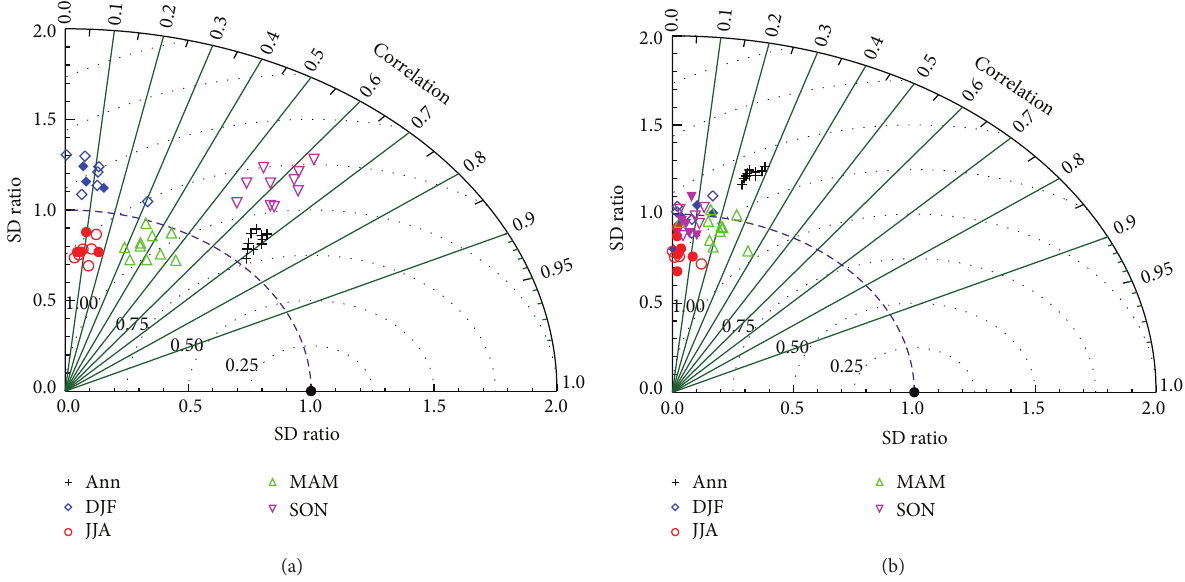
Figure 1: Taylor diagram is displayed in polar coordinate for pattern comparison between reference and other runs in terms of correlation, standard deviation (SD), and root mean square error (RMSE) for (a) zonal wind and (b) meridional wind. SD ratio is the standard deviation of each model run to that of the radiosonde observation taken as a reference. SD ratio is the radial distance from the origin; the RMSE is the distance to the reference point; the azimuthal position gives the correlation coefficient. The colored symbols represent monthly data used for each run from 1979 to 2005 (annual, black plus; December, January, and February (DJF), blue diamond; March, April, and May (MAM), green upward triangle; June, July, and August (JJA), red circle; September, October, and November (SON), magenta downward triangle). Open (filled) symbols represent positive (negative) correlations between each ensemble member and radiosonde observation (black filled